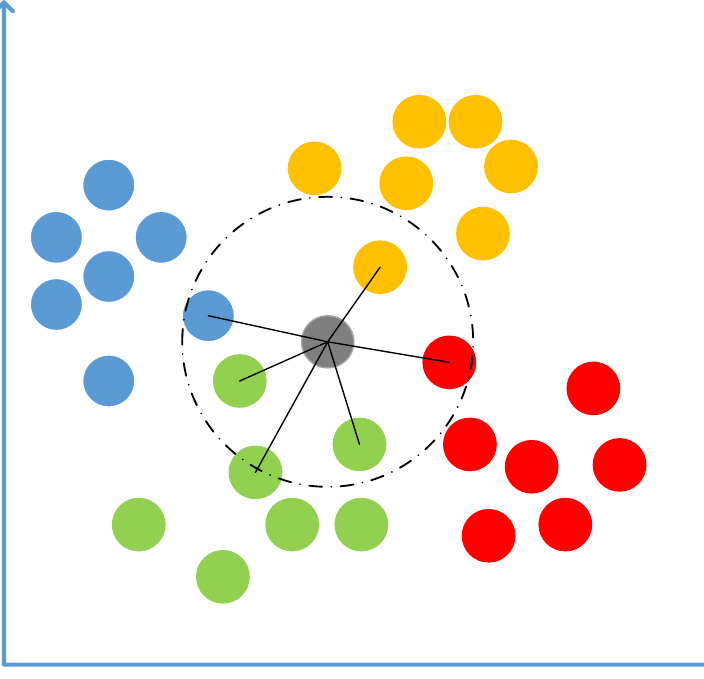
Figure 5. Diagram of the basic principle of the KNN classifier. Blue, orange, green and red colors represent different categories of known samples. Grey represents unknown samples.